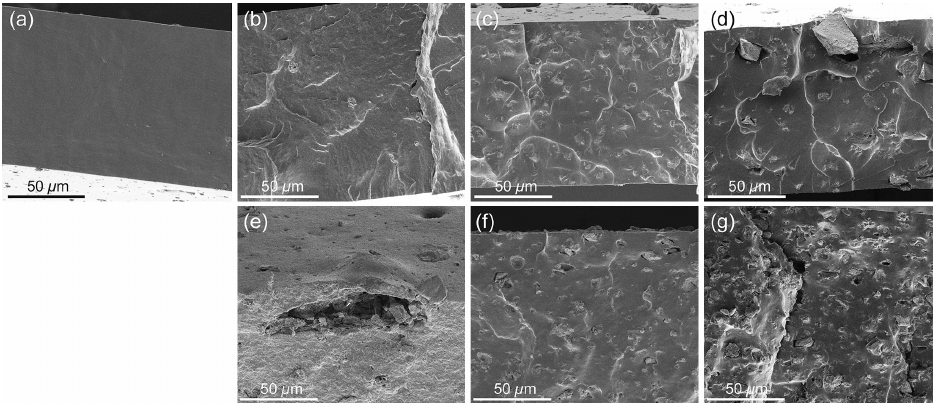
Figure 4. Cross-sectional SEM images of elastomeric biomaterials (silicones containing or not 10 wt % bioactive glass (BG45S5) particles) for cardiac tissue repair: ( a ) pure silicone; ( b ) silicone with nano-sized bioactive glass (nano-BG); ( c ) silicone with BG microparticles by Schott (Schott-BG); and ( d ) silicone with BG microparticles by Mo-Sci-Corporation (Mo-Sci-BG); and ( e – g ) the respective BG-containing composite films after four weeks of immersion in simulated body fluid (SBF). Images from Cohrs et al. [75] © Springer.